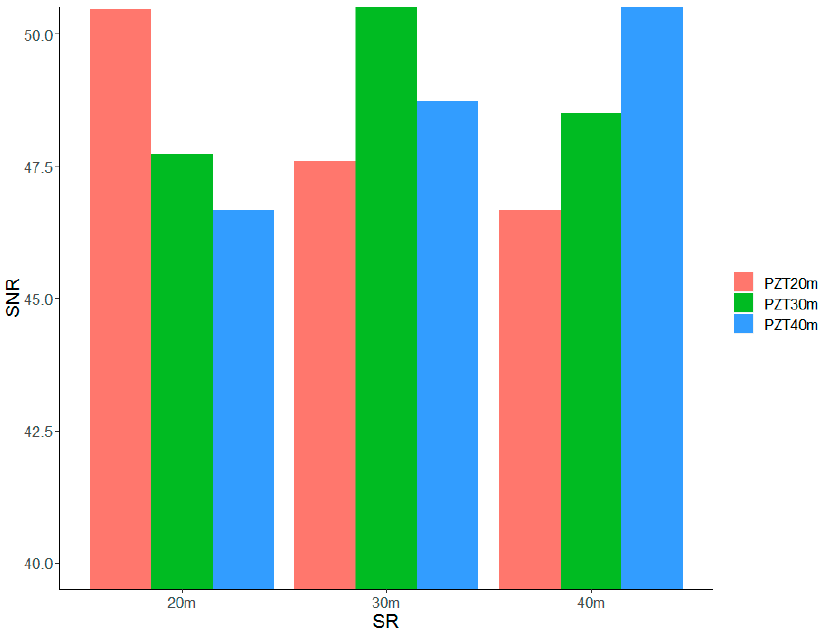
ff erent SRs (unit is Figure 10. The SNRs of three PZTs at different SRs (unit is dB). Figure 10. The SNRs of three PZTs at different SRs (unit is dB). Figure 10. The SNRs of three PZTs at di